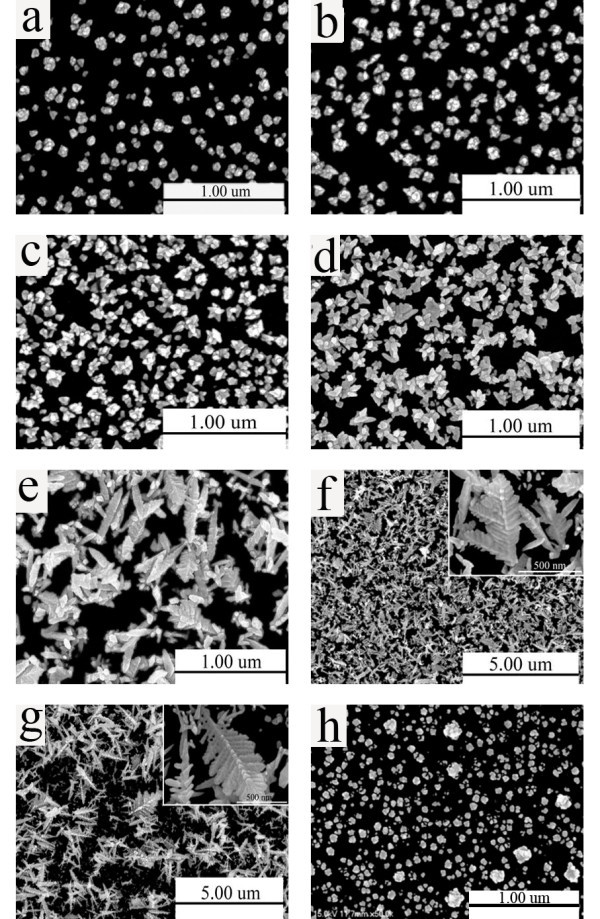
SEM images of Pd nanostructures electrodeposited on ITO. (1) Cyclic voltammetry deposition in 1.0 mM H2PdCl4 + 0.33 M H3PO4 electrolyte for 5 cycles (a), 10 cycles (b), 20 cycles (c), 35 cycles (d), 75 cycles (e), 100 cycles (f), and 200 cycles (g), and (2) potentiostatic deposition in 1.0 mM H2PdCl4 + 0.33 M H3PO4 electrolyte (h); inset is at a higher magnification.